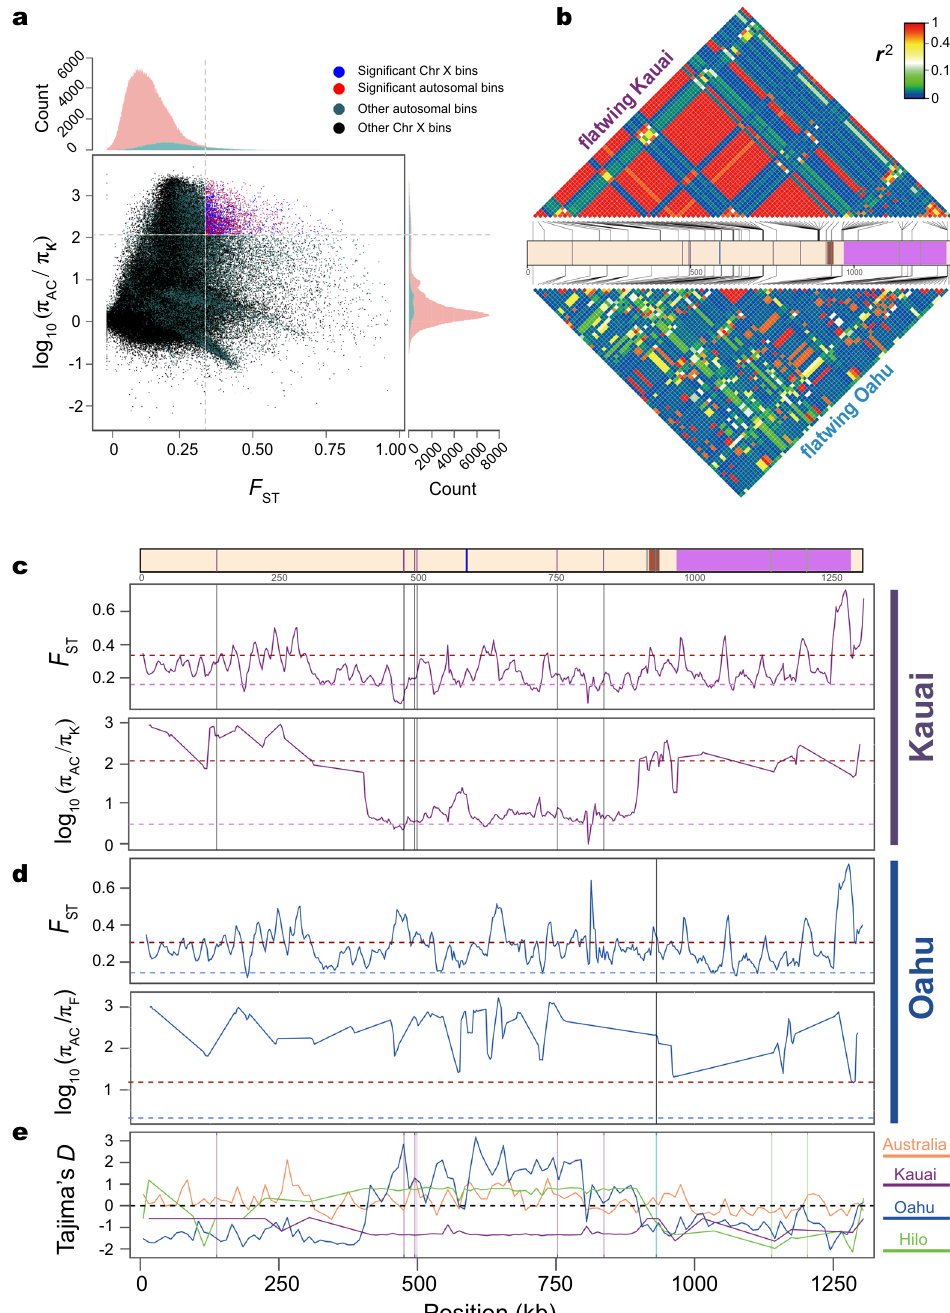
Fig. 4 Parallel adaptation is associated with different signatures of selection on putative fl atwing hotspot, scaffold 18404. a Loci showing signatures of selective sweeps in wild Kauai fl atwing males were identi fi ed by examining the distribution of fi xation index ( F ST ) and relative diversity (log 10 [ θ π ,unselected_normal-wing / θ π ,selected_ fl atwing ]) between fl atwing Kauai individuals and normal-wing Australian individuals. Datapoints represent 10 kb sliding windows calculated in 2.5 kb increments across the entire genome. Blue points and red points correspond to X chromosome and autosomal bins, respectively, showing the most signi fi cant selective-sweep signatures (top 5% of the empirical distribution). b Patterns of linkage disequilibrium (LD) along the fl atwing-associated scaffold 18404. Top and bottom heatmaps show pairwise LD ( r 2 ) between SNPs (top — Kauai, bottom — Oahu), and SNPs were fi ltered as detailed in the ‘ Method ’ section to ensure LD is comparable between fl atwing males from Kauai vs. Oahu. The colour scale refers to the value of r 2 . Protein-coding genes and fl atwing-associated SNPs are indicated by blocks and bars with different colours respectively ( Prospero = brown, Doublesex = purple) in the middle panel. c – e , Signatures of selection on scaffold 18404 associated with parallel evolution in Hawaiian populations. Genes and fl atwing-associated SNPs are shown in the top panel using the same scheme as in b . F ST and π were calculated using sliding-window analyses with 10 kb windows for c Kauai and d Oahu. π ratio = θ π ,unselected_normal-wing / θ π ,selected_ fl atwing . Horizontal dashed lines represent mean whole-genome value for the values shown in each panel, and dark red horizontal dashed lines in c and d represent the top 5% threshold values. e Tajima ’ s D for all wild-caught individuals. Kauai fl atwing (purple), Oahu (blue, all samples combined), Hilo normal-wing (green), Australian normal-wing (orange). The dashed horizontal line indicates the Tajima ’ s D null hypothesis for